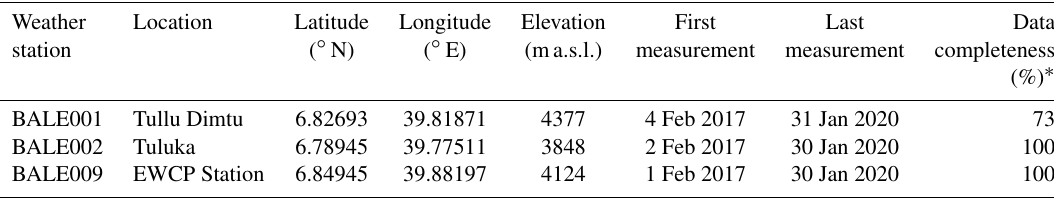
Table D2. Overview of the automatic weather stations installed on the Sanetti Plateau. Weather